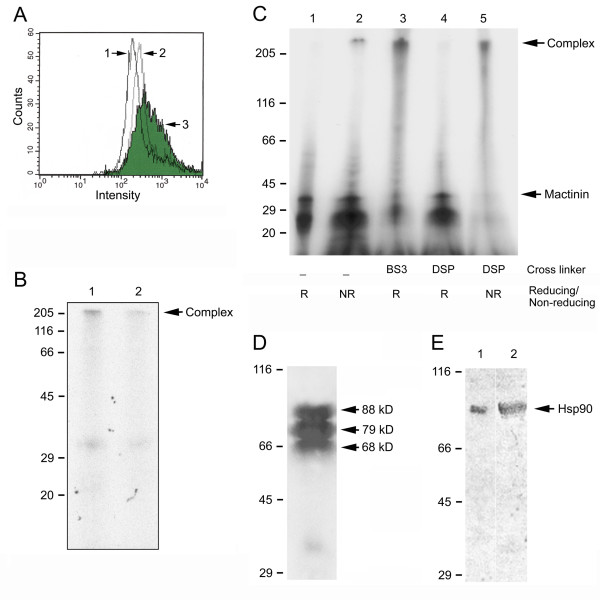
Mactinin binds to a Hsp90 containing complex on the surface of monocytoid cells. A: Mactinin binds directly to peripheral blood monocytes. Monocytes incubated without (plot 1) or with (plot 3: shaded area) 100 nM mactinin were analyzed by flow cytometry to detect mactinin bound to the cell surface. The control condition (cells incubated with mactinin and stained with isotype matched IgG1 antiserum) is shown in plot 2. One of four representative experiments is shown. B: Mactinin binds specifically in a high molecular weight complex on monocytoid HL-60 cells. HL-60 cells were pre-incubated with or without excess unlabeled (cold) mactinin, and then with [125I]mactinin. Cell lysate was resolved by 12% SDS-PAGE under non-reducing conditions, and [125I]mactinin detected using autoradiography. Lane 1: high molecular weight complex on cells incubated with [125I]mactinin alone. Lane 2: marked reduction in bound [125I]mactinin in cells pre-incubated with unlabeled mactinin. C: Mactinin binds to monocytoid HL-60 cells. HL-60 cells were biotinylated and then incubated for 1 h at 4°C with 100 nM [125I]-mactinin, washed, and incubated without or with the cross-linkers DSP or BS3, lysed, and resolved by 6–20% gradient SDS-PAGE under non-reducing or reducing conditions. Lane 1: 31 kD radiolabeled mactinin alone, reducing conditions (no cells). Lane 2: radiolabeled mactinin bound to a high molecular weight complex on HL-60 cells, non-reducing conditions, no cross-linker. Lane 3: retention of most of the radiolabeled mactinin in the complex in presence of the impermeable, non-cleavable cross-linker BS3, reducing conditions. Lane 4: 31 kD radiolabeled mactinin separated from the binding complex under reducing conditions, cleavable cross-linker DSP. Lane 5: retention of nearly all of the radiolabeled mactinin in the complex in presence of the cross-linker DSP, non-reducing conditions. D: Mactinin binds to 3 distinct proteins on HL-60 cells. HL-60 cells were biotinylated (to detect cell surface proteins that bind to mactinin) and incubated with 100 nM mactinin. The HL-60 cell protein-mactinin complex (the material in lane 5 in Fig. 2C) was electroeluted, reduced, run over a mactinin column, and the bound proteins were resolved by 6–20% gradient SDS-PAGE. Biotinylated HL-60 proteins (88, 79 and 68 kD) that bound to the mactinin affinity column were detected by Western immunoblotting. E: Identification of Hsp90 in the mactinin-binding complex. The membrane shown in Fig. 2D was stripped and re-probed using an anti-Hsp90 antibody. A single 90 kD band was detected (lane 1). Recombinant Hsp90 was run in lane 2.